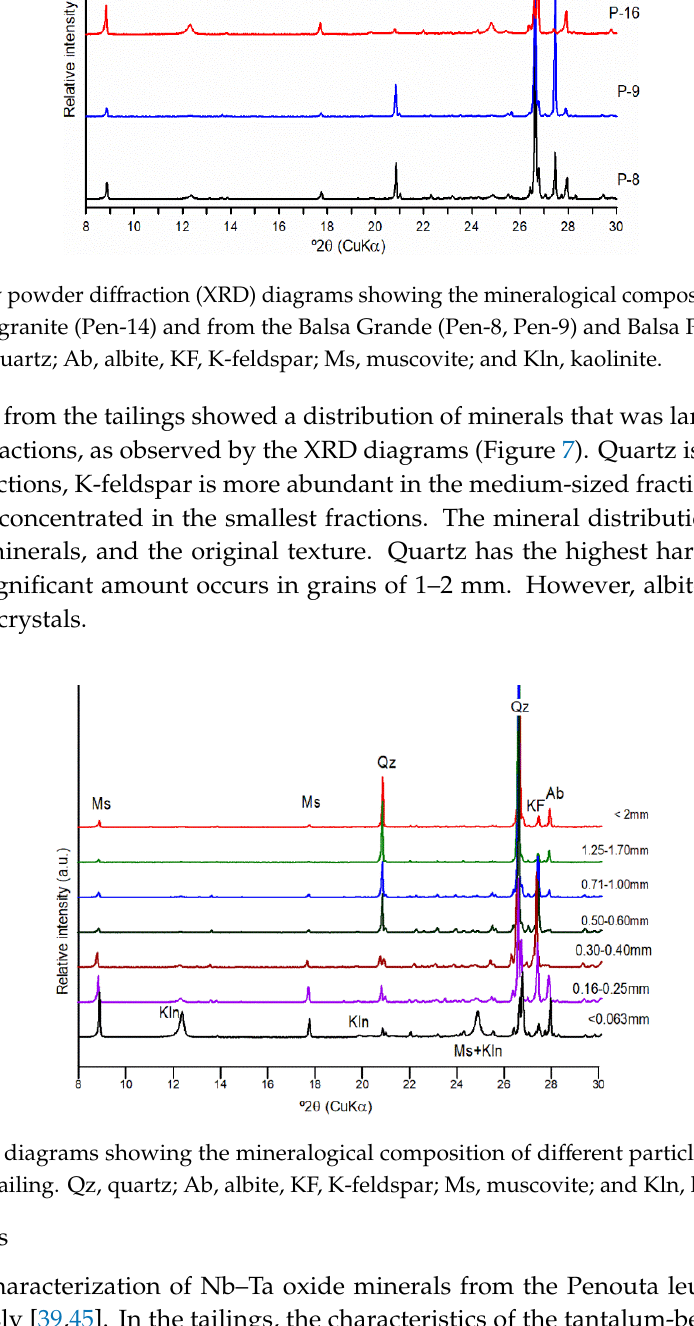
Figure 7. XRD diagrams showing the mineralogical composition of different particle sizes from the Balsa Grande tailing. Qz, quartz; Ab, albite, KF, K-feldspar; Ms, muscovite; and Kln, kaolinite.